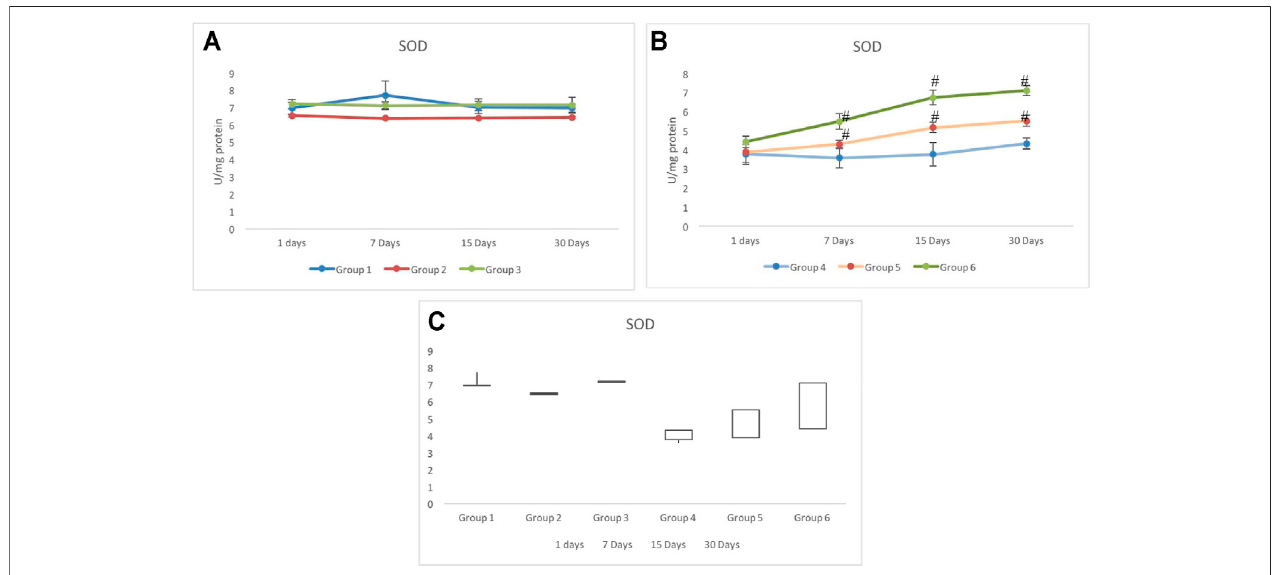
FIGURE 4 | Alteration in the activity of superoxide dismutase (SOD) in CRE/CRE-AgNP pretreated animals. (A) Non-irradiated groups. (B) Irradiated groups. (C) Gain/lossintheactivity ofsuperoxidedismutase. * p < 0.05signi fi cancelevel wasmeasured against group1. # p < 0.05signi fi cance levelwasmeasured againstgroup 4.